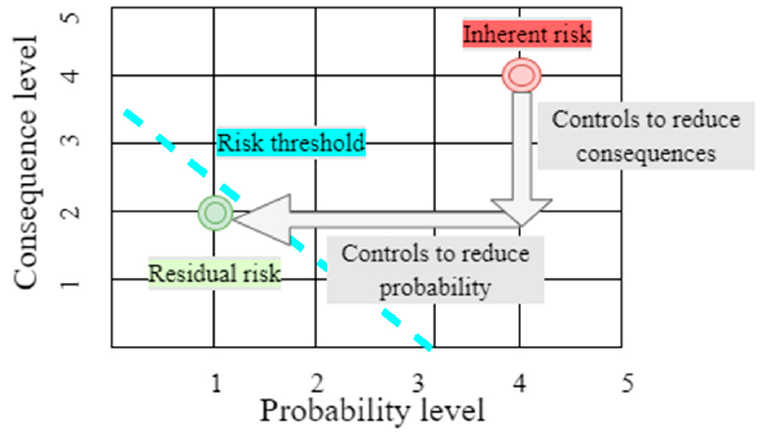
Figure 3. Inherent and residual risk idea in the risk reduction process. An adaptation based on source [22].